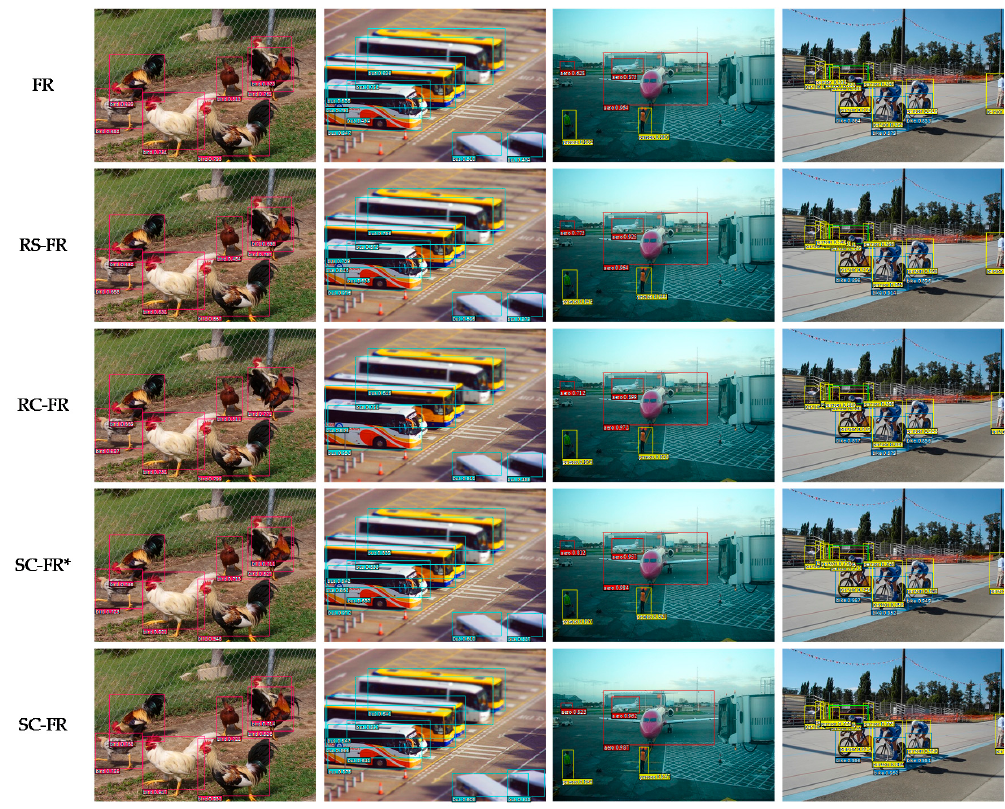
Figure 5. Some examples of detection results of the proposed algorithm ablation experiment. Sensors 2020 , 20 , x FOR PEER REVIEW